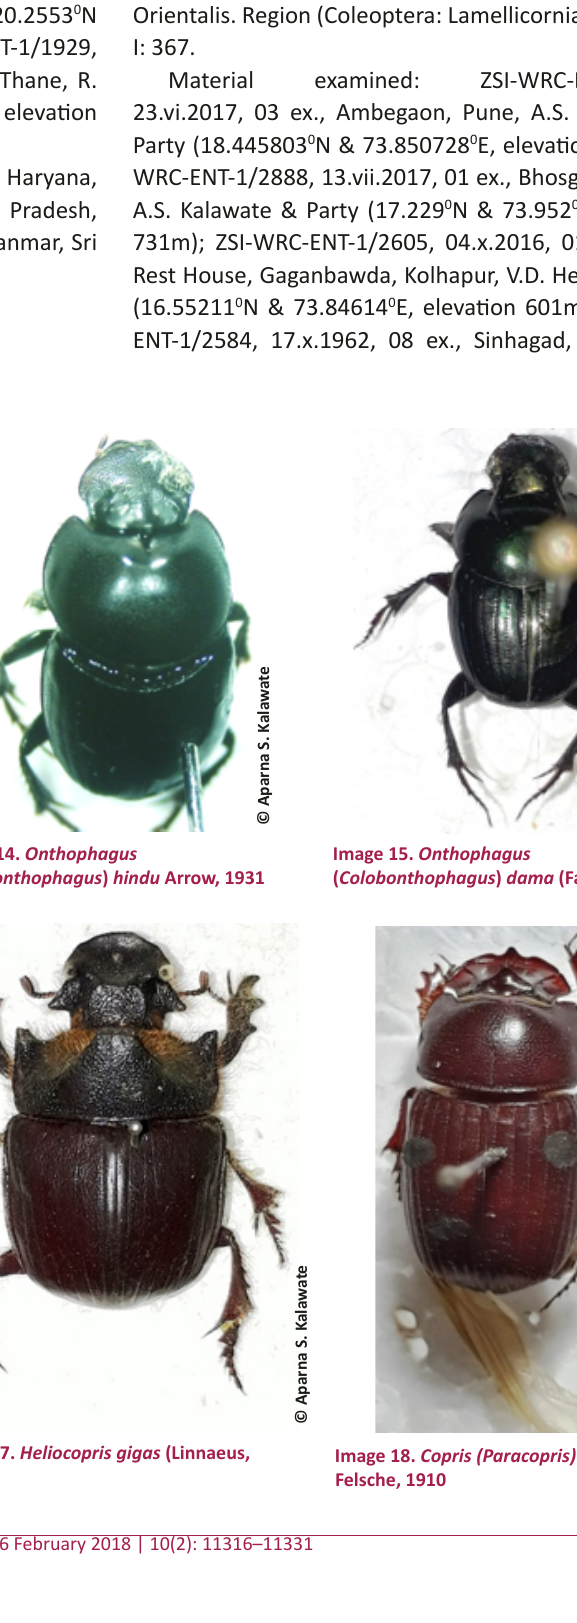
Image 17. Heliocopris gigas (Linnaeus, 1764)